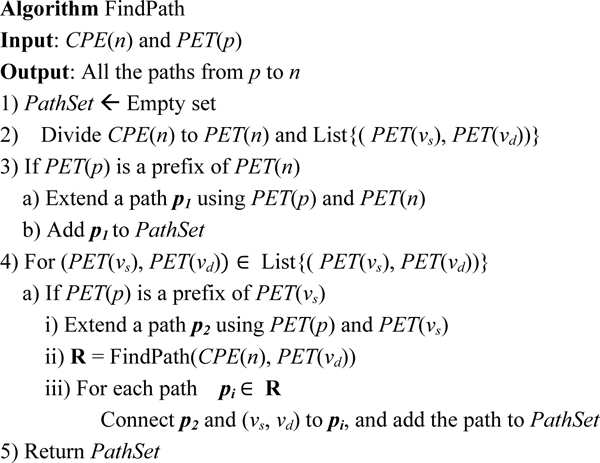
Algorithm: FindPath.